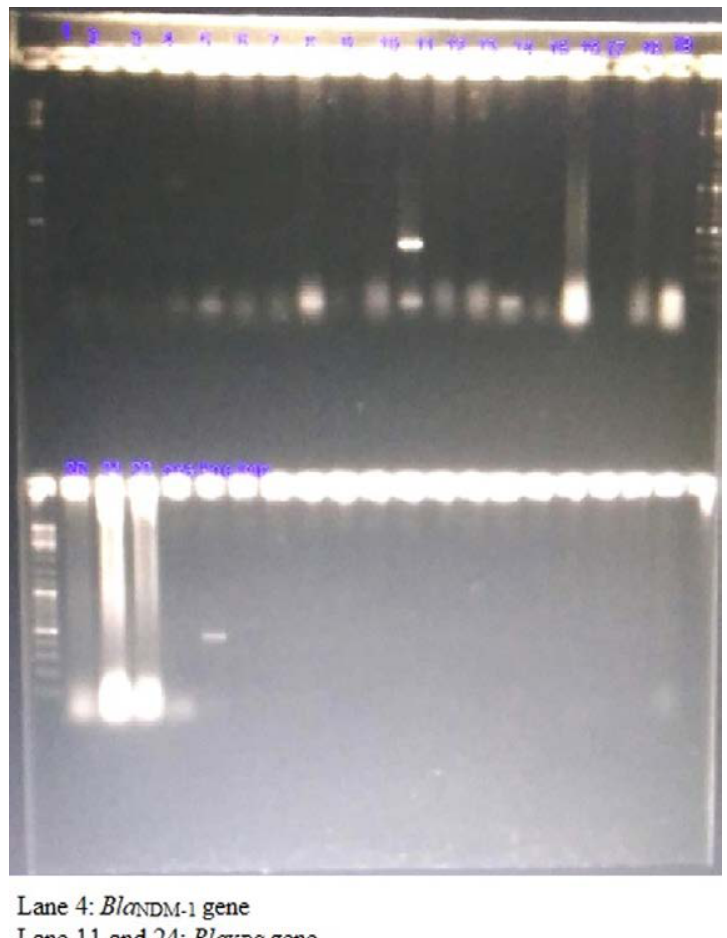
, Bla , Bla and Bla genes by multiplex PCR in the drug resistant Acinetobacter IMP VIM KPC NDM-1